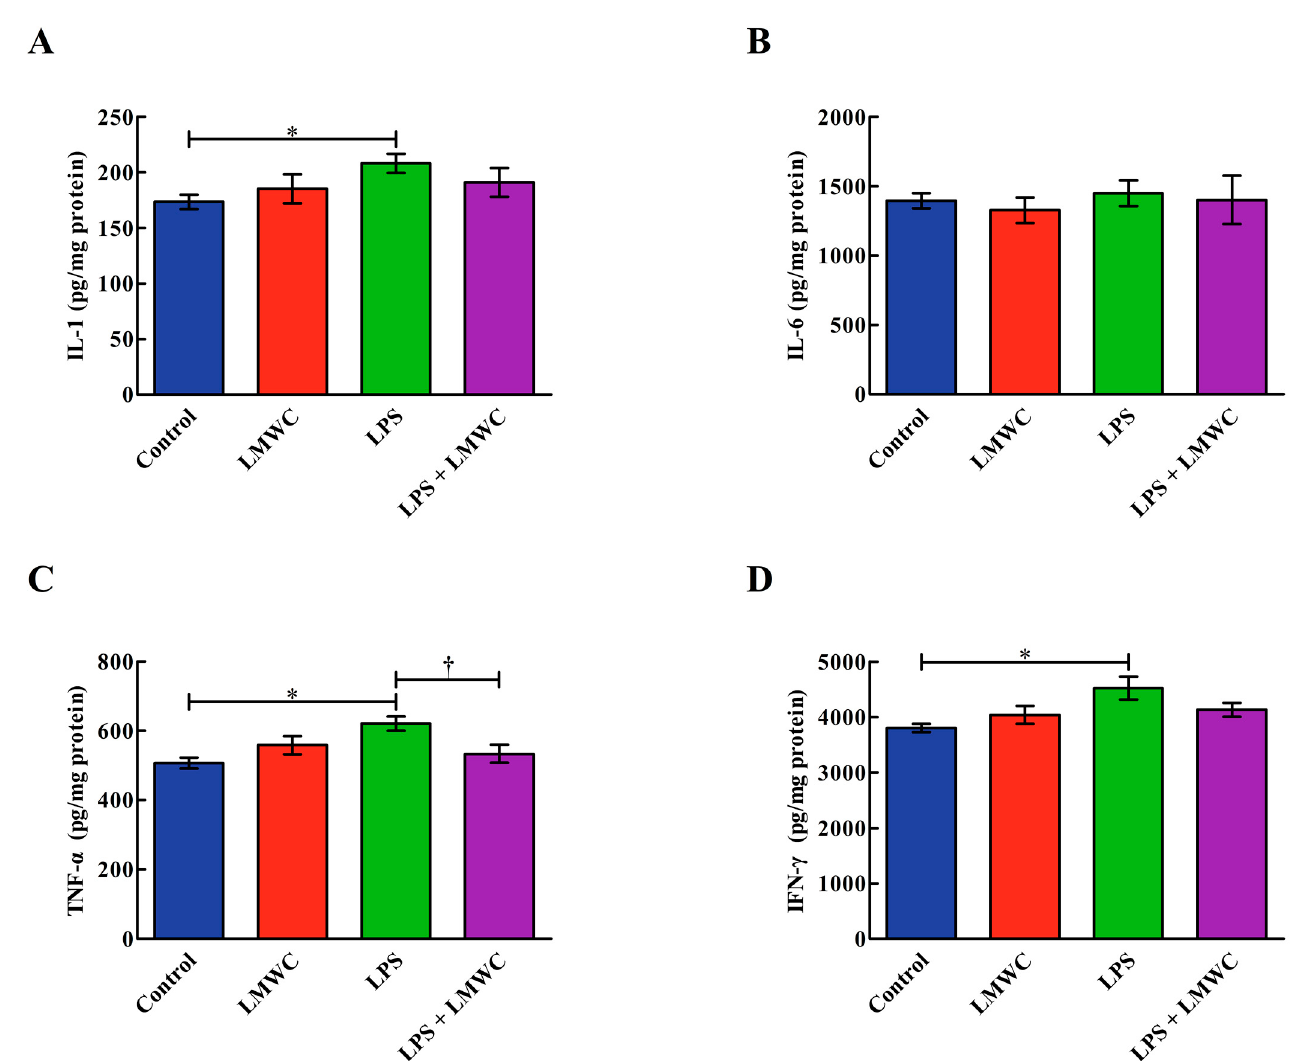
Figure 3. Effects of LMWC on the proinflammatory cytokine concentrations in LPS-treated IPEC-J2 cells. ( A ) IL-1: interleukin-1. ( B ) IL-6: interleukin-6. ( C ) TNF- α : tumour necrosis factor- α . ( D ) IFN- γ : interferon- γ . Cells were pretreated with LMWC (400 µ g/mL) for 2 h, followed by cotreatment with LPS (5 µ g/mL) for another 6 h. Data are presented as the mean ± standard error ( n = 4). * Means significant difference compared with the control group ( p < 0.05). † Means significant difference compared with the LPS group ( p < 0.05).